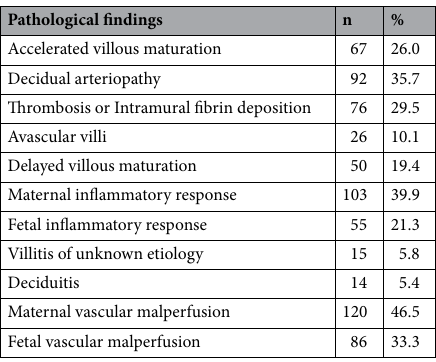
Table 1. Pathological findings detected in 258